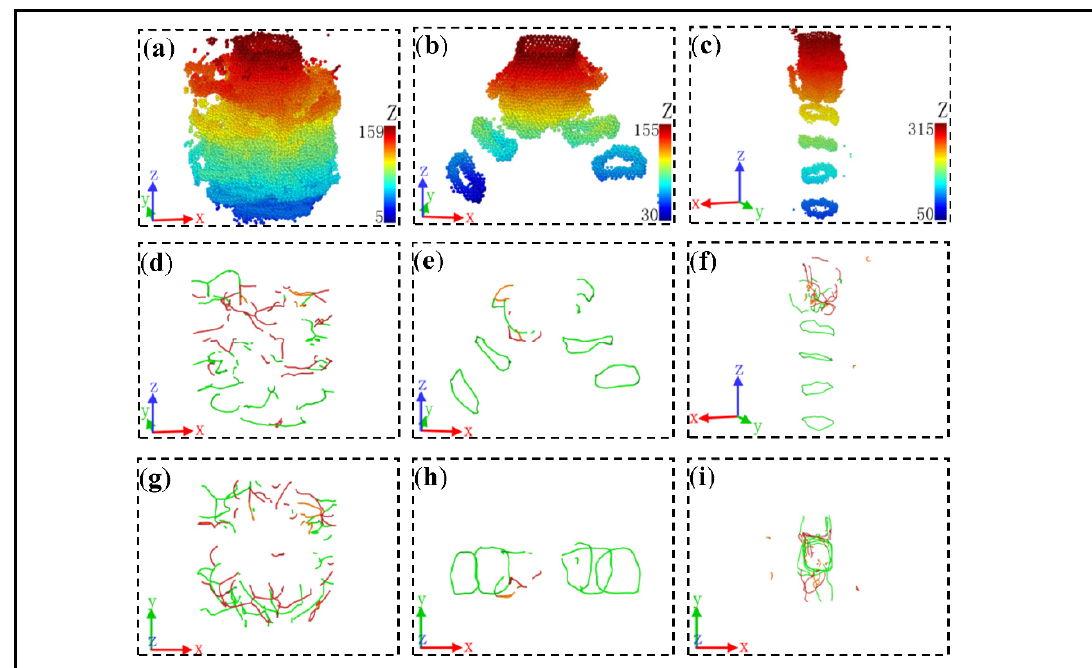
Figure 8. Dislocation and dislocation curves during plastic deformation of nanoindentation on different 6H-SiC crystal planes. ( a – c ) are the (0001), (1100) and (2110) indentation surfaces at the plastic deformation stage, ( d – f ) are the curve of the (0001), (1100) and (2110) plastic deformation phase of dislocation, ( g – i )are the top views of dislocation curves of (0001), (1100) and (2110) crystal